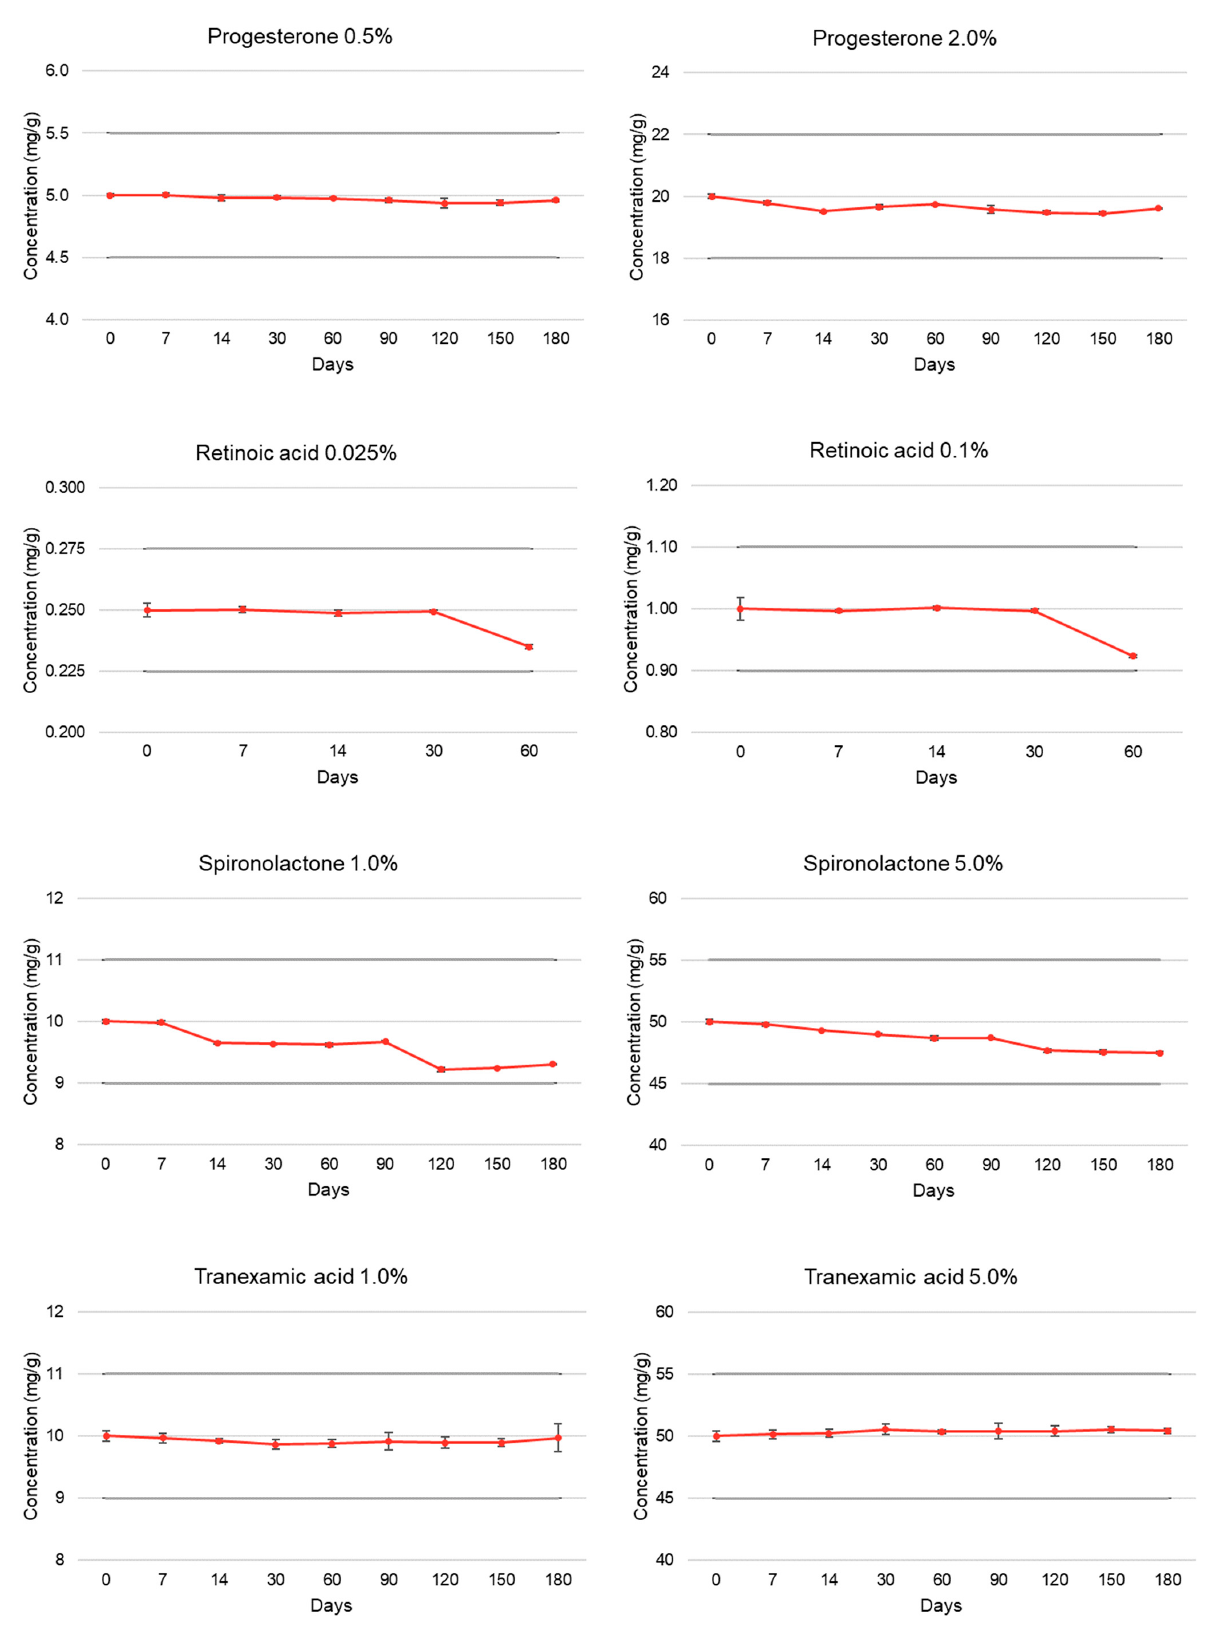
Figure 1. Active pharmaceutical ingredients” chemical stability in Cleoderm™, in absolute amounts, measured by high-performance liquid